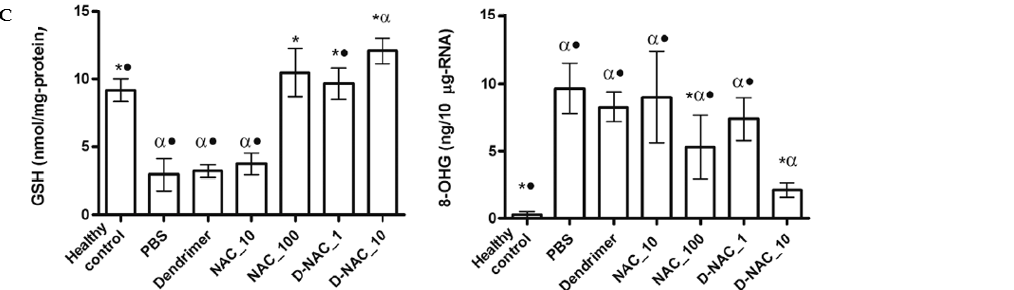
Figure 7. Effects of a NAC-based nanosystem on myelination and neuronal injury in a dendrimer- based therapy (D-NAC) against neuroinflammation and cerebral palsy (CP). ( A ) Confocal microscopy results were obtained with brain sections harvested and stained for myelin basic protein (MBP) using DAB staining. The images show a decrease in the MBP staining in the corona radiata, internal capsule, and external capsule following day 5 of life in endotoxin kits treated with PBS compared with healthy controls. ( B ) Microtubule-associated protein 2 (MAP2) labeling was used to detect mature neurons in the caudate area of the basal ganglia. Treatment with D-NAC (10 mg/kg) significantly enhanced the number of neurons ( p < 0.01) compared with those of healthy controls. ( C ) Determination of the amounts of 8-hydroxyguanosine (8-OHG) and GSH to assess oxidative injury and inflammation in CP and healthy rabbits. The markers of oxidative injury were compared in the brain’s periventricular region (PVR) after treatment of CP kits with D-NAC 1, D-NAC 10, and free drug at high concentrations (NAC 100). (* p < 0.05 when compared to PBS; α p < 0.01 when compared to control and • p < 0.01 when compared to D-NAC_10) Adapted with permission from [92]. Copyright {2018} Science-HHS Public Access